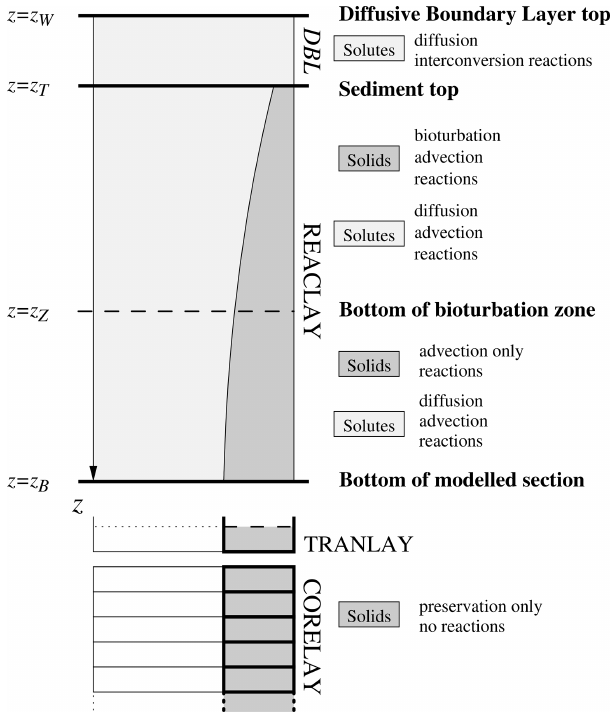
Figure 1. Partitioning of the sediment column in MEDUSA: an op- tional diffusive boundary layer (DBL) on top of the main part of the model sediment where diagenetic reactions and advective–diffusive transport take place (REACLAY), the transition layer (TRANLAY) and the core represented by the stack of layers (CORELAY). The bottom of the bioturbation zone may coincide with the bottom of REACLAY. If the optional DBL is omitted, z W = z T . See text for further